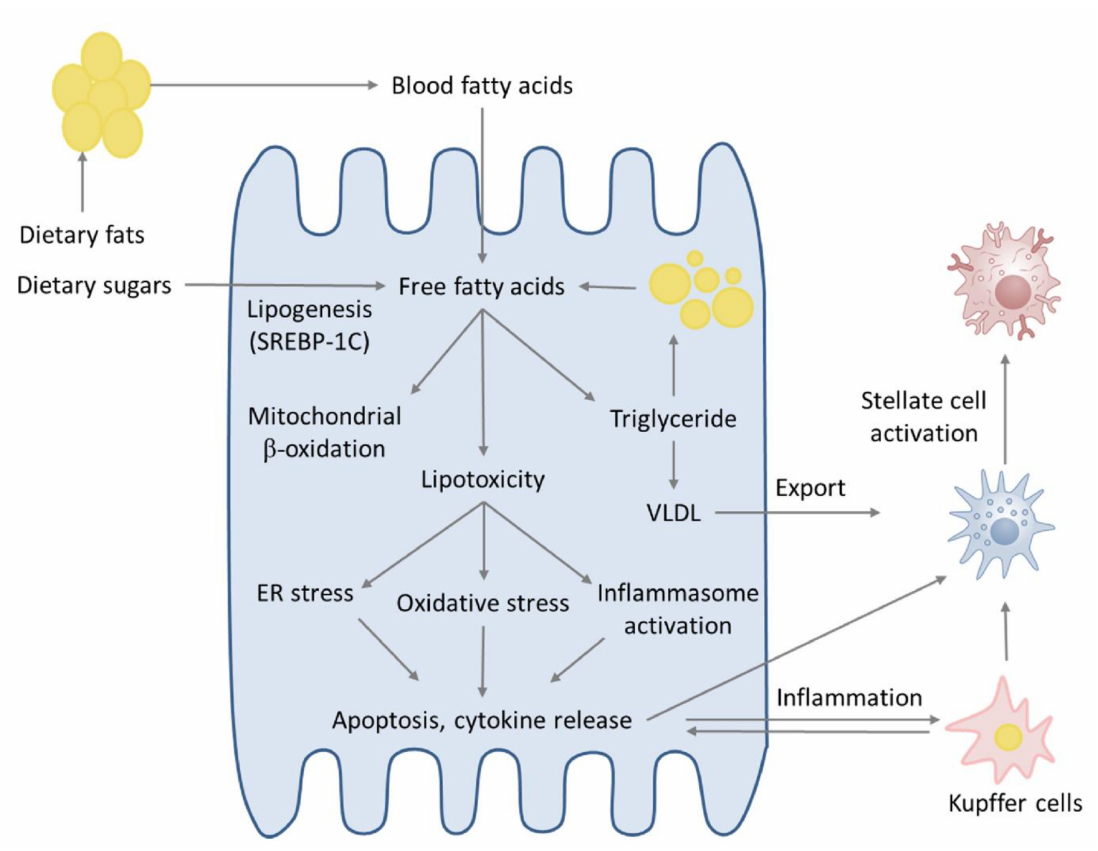
Figure 1. Non-alcoholic steatohepatitis (NASH) pathogenesis. Free fatty acids have a key role in the pathogenesis of NASH. Free fatty acids primarily originate from lipolysis of triglycerides in adipose tissue; insulin resistance may contribute to NASH through a lipolysis dysregulation. The other major contributor to the free fatty acid liver accumulation is de novo lipogenesis (DNL), resulting from hepatocyte-mediated conversion of fructose to fatty acids. Fatty acids, in hepatocytes, are directed toward mitochondrial beta-oxidation or re-esterification to form triglycerides. Triglycerides can be exported into the blood as VLDL or stored in lipid droplets. When the beta-oxidation or triglyceride conversion of fatty acids is overwhelmed, lipotoxicity occurs, leading to ER stress, oxidative stress and inflammasome activation. These processes are responsible for NASH development, resulting in hepatocellular injury, inflammation and